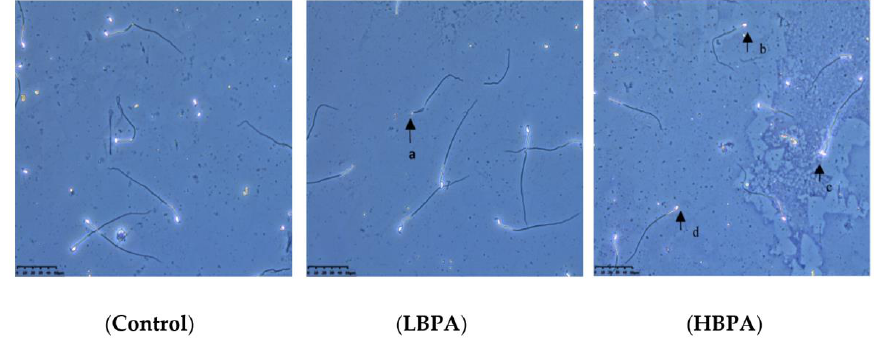
microcephalus malformation; (b,d) hookless malformation; (c) dicephaly. Magnification: Control, malformation; ( b , d ) hookless malformation; ( c ) dicephaly. Magnification: Control, LBPA, and HBPA,